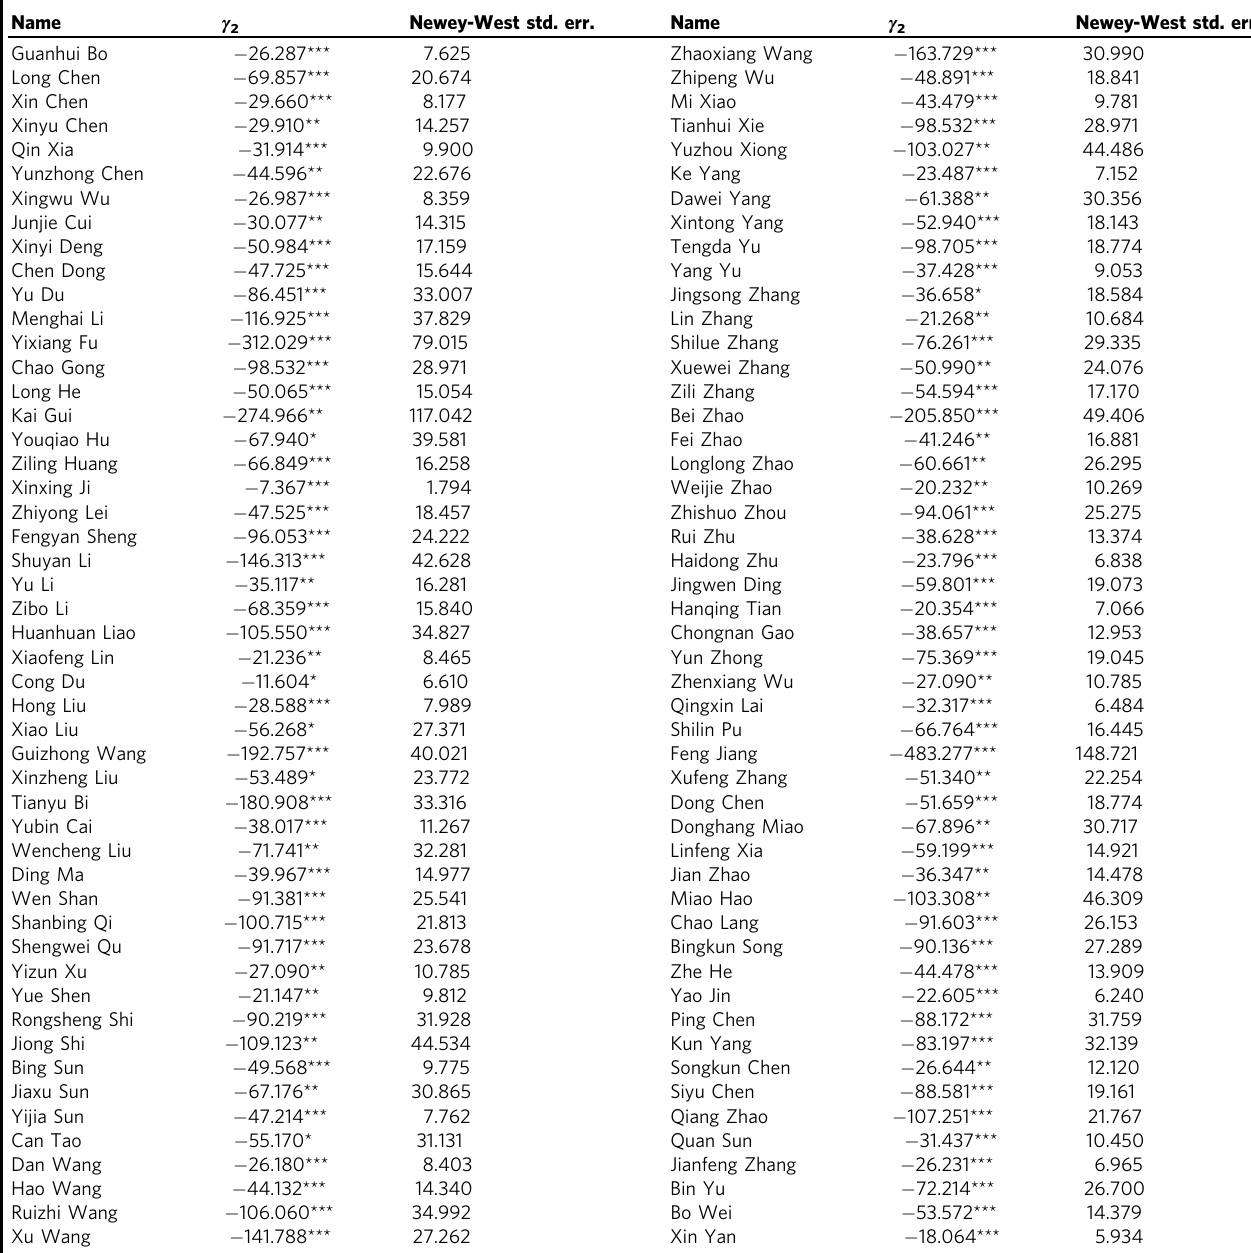
Table 2 Herding behavior measurement of SIFs from the perspective of fund managers.